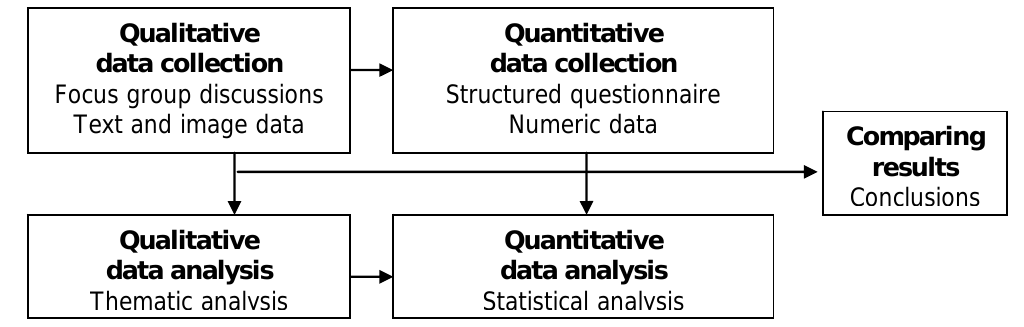
Figure 1: Exploratory, sequential mixed-method